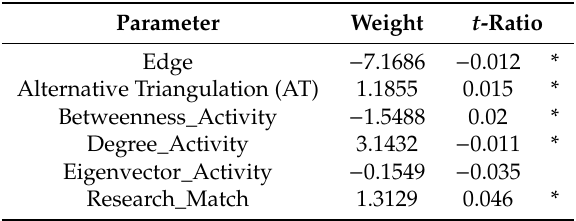
Table 2. Estimated